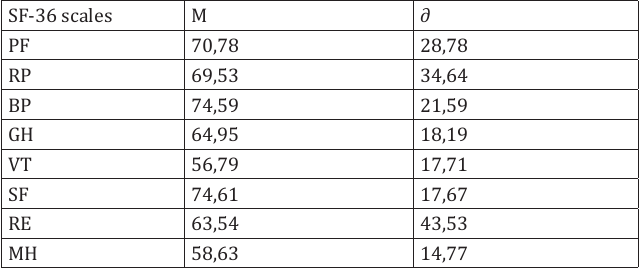
Averages of 8 SF-36 scales (N=64).